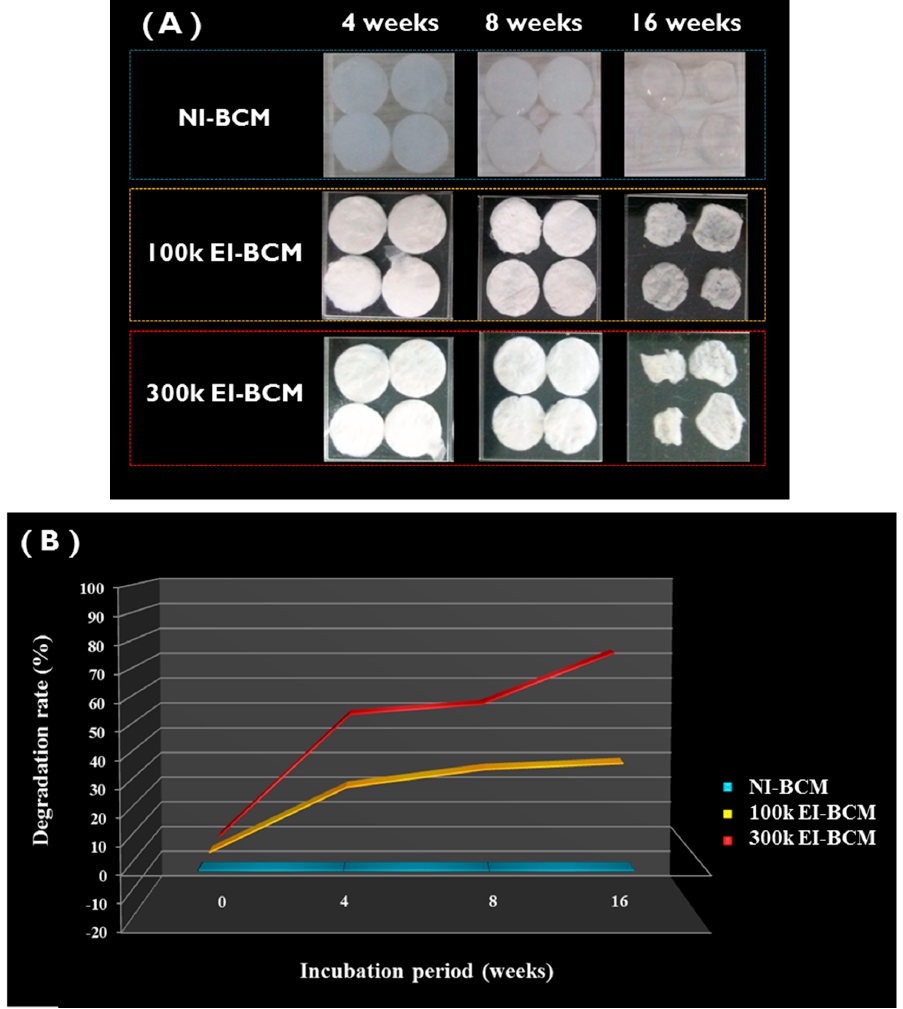
Figure 5. In vitro degradation of BCMs. ( A ) The degradation rates of NI-BCMs, and 100k and 300k EI- BCMs were measured after immersion in PBS for 4, 8, or 16 weeks. ( B ) Degradation rates of